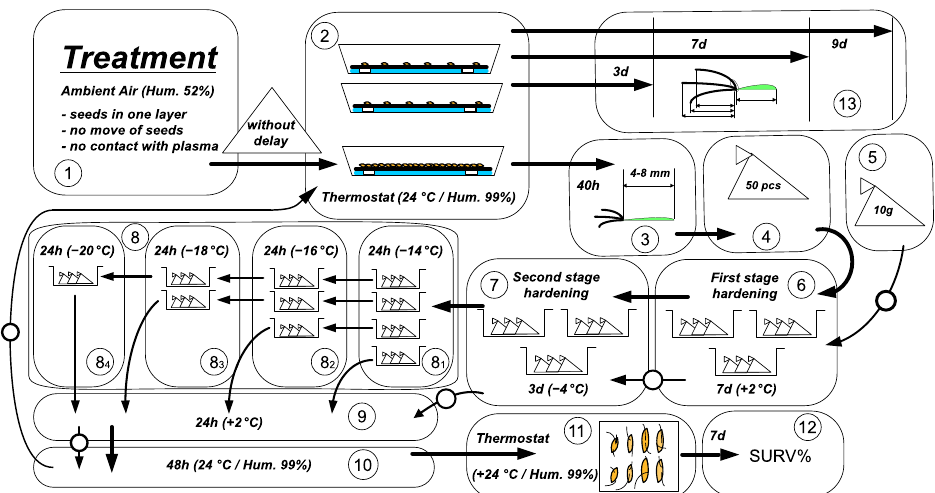
Figure 1. Seed and seedling handling diagram. Temperature ( ◦ C) and humidity (%) of air at different (cid:13) (cid:13) stages are indicated in brackets. The steps are 1 seed treatment, 2 germination in thermostat, (cid:13) (cid:13) (cid:13) selection of seedlings after 40 h, 4 formation of samples of 50 pieces, 5 preparation of seed 3 (cid:13) (cid:13) samples for hardening, 6 the first stage of cold hardening (7 days), 7 the second stage of cold (cid:13) (cid:13) (cid:13) (cid:13) hardening (3 days), 8 freezing, 9 defrosting (24 h), 10 thawing (48 h), 11 germination (7 days), (cid:13) (cid:13) and 12 counting the proportion of surviving seedlings and 13 morphophysiological analysis of seedlings after 3, 7, and 9 days of germination. The arrows are marked with a circle for the seeds, and the arrows are solid for seedlings.